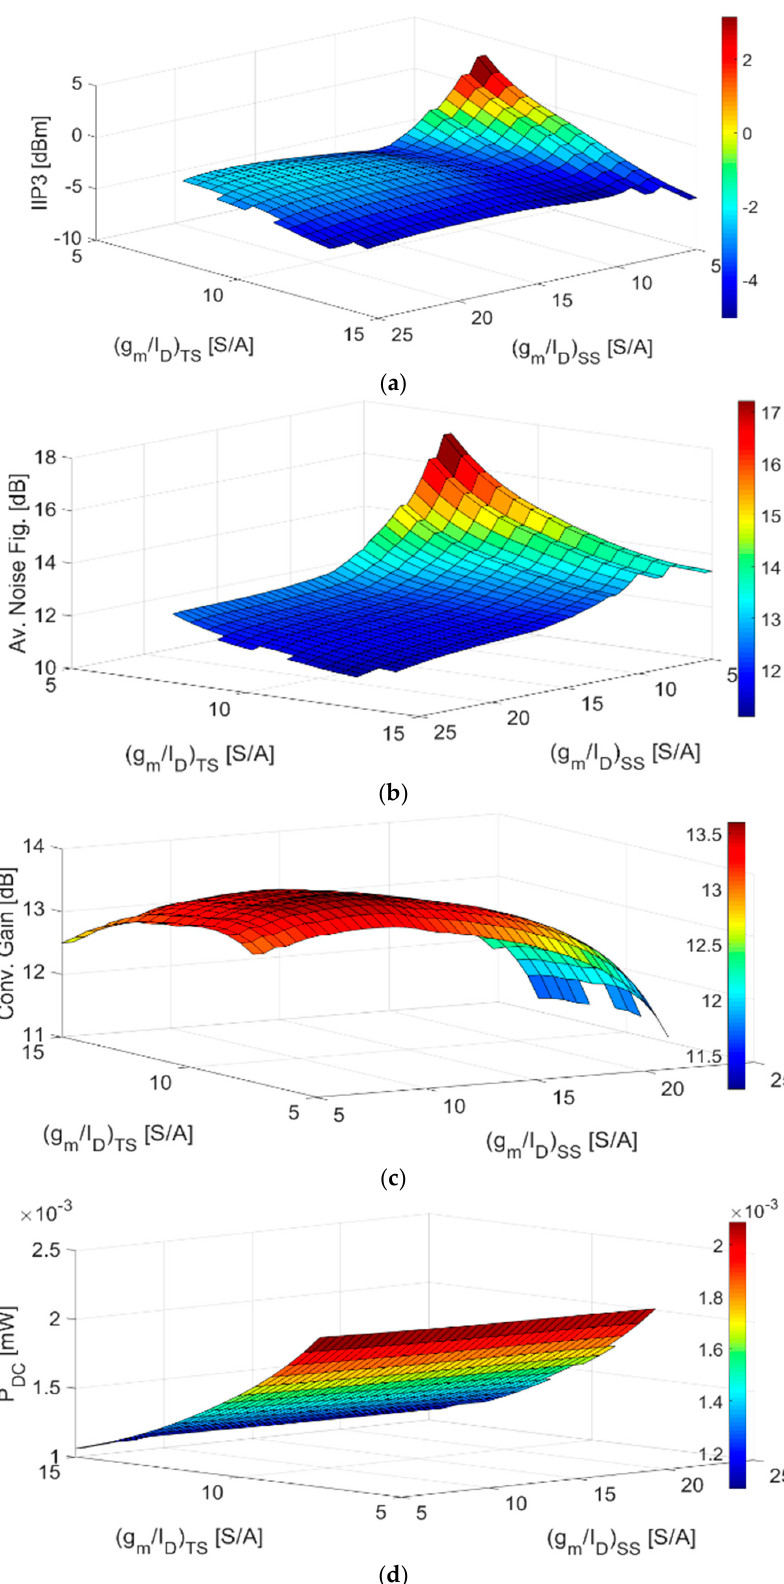
Figure 6. ( a ) Mixer IIP3 vs. g m /I D(TS) and g m /I D(SS) ratios. ( b ) Average noise figure vs. g m /I D(TS) and g m /I D(SS) ratios. ( c ) Mixer conversion gain vs. g m /I D(TS) and g m /I D(SS) ratios. ( d ) Mixer power dissipation vs. g m /I D(TS) and g m /I D(SS) ratios.